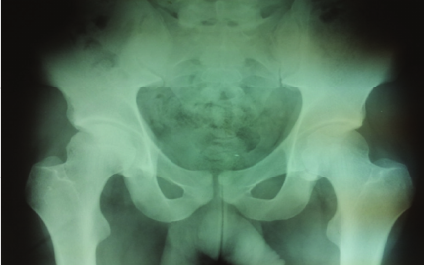
Figure 2: Concentric reduction of both femoral heads after close